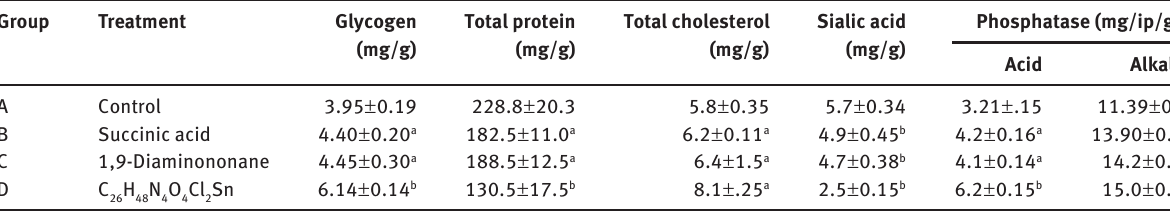
Table 8 Testicular biochemistry of the starting materials and their tin(II) complex.